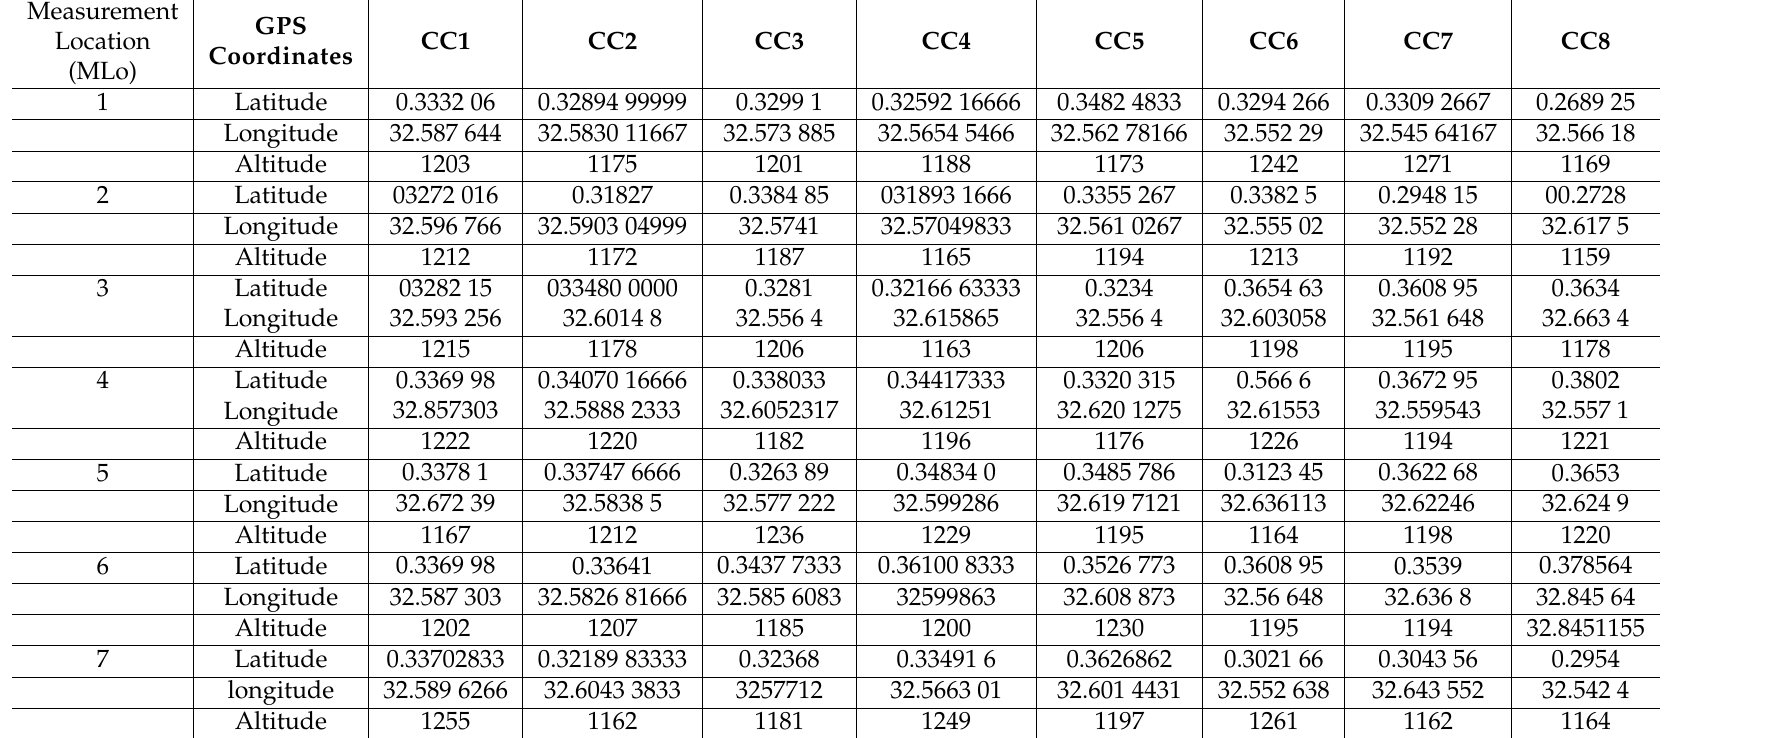
Table 2. GPS coordinates for the different measurements location on the different concentric